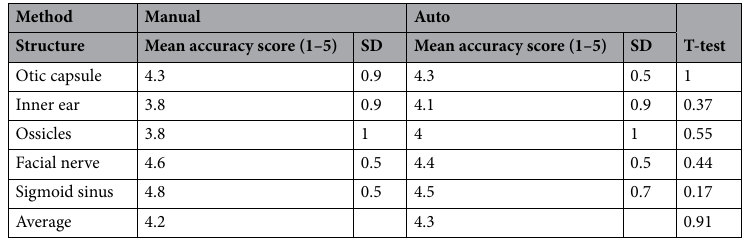
Table 4. Expert reviewer ratings for the manually segmented and autosegmented temporal bone computed tomography scans. SD: Standard